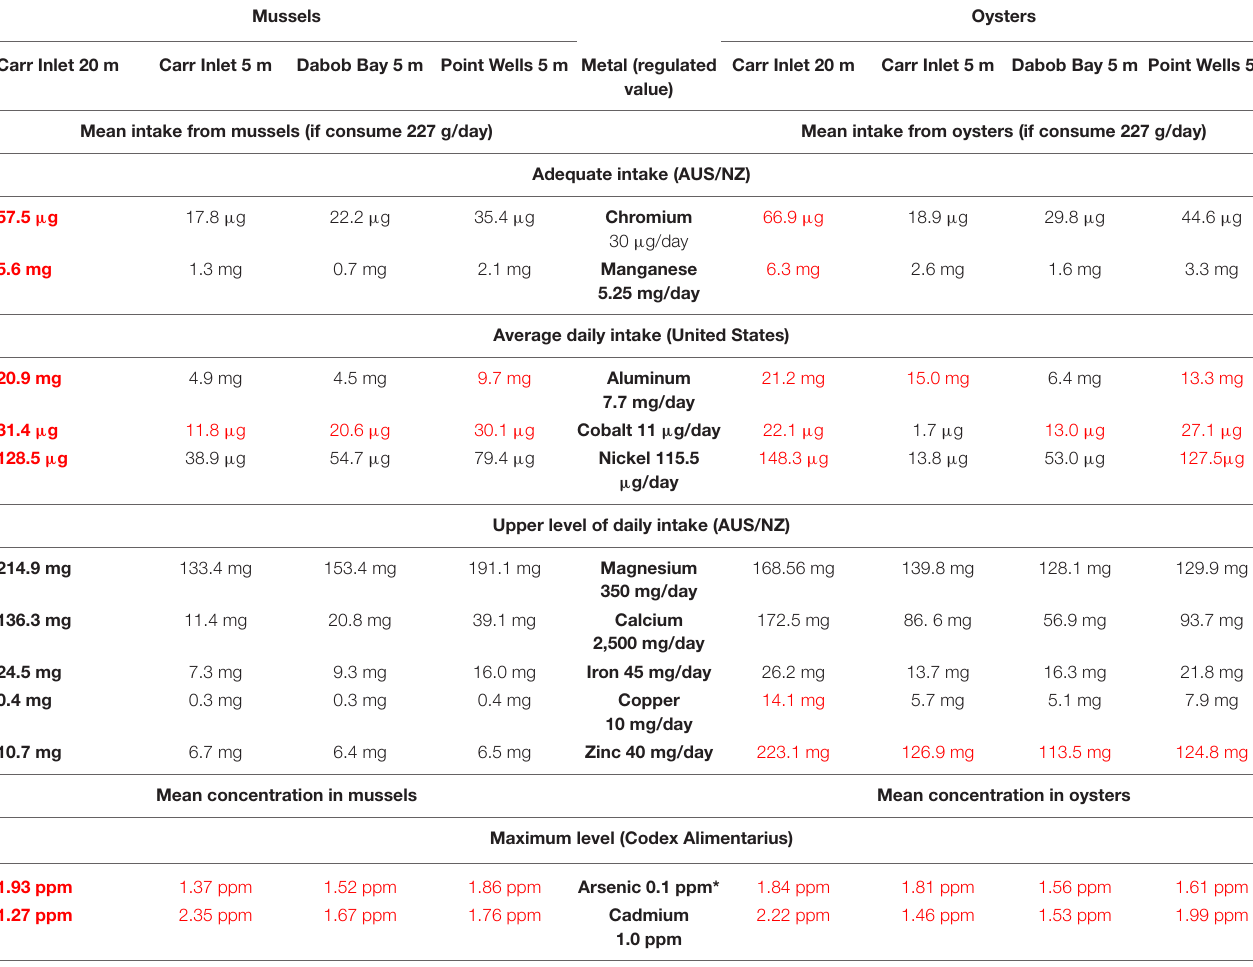
TABLE 2 | Average concentrations of metals found in mussels and oysters from each of the four sites compared to the average or maximum recommended levels available for each metal.